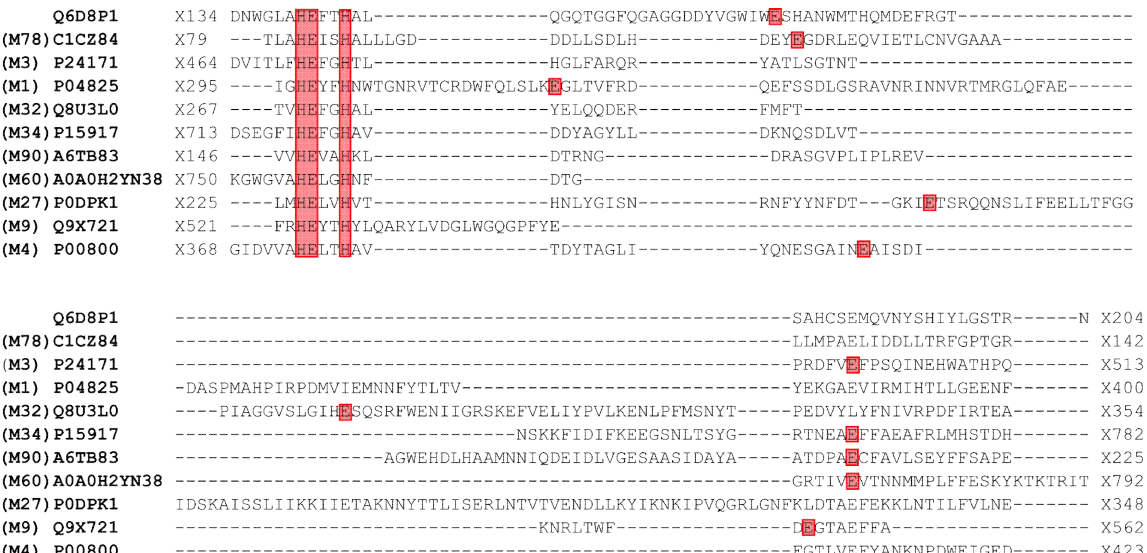
Figure 2. The alignment of the amino acid sequence of the Svx protein of Pectobacterium atrosepticum ( Pba ) (UniProt ID: Q6D8P1) with other bacterial gluzincin metallopeptidases with experimentally determined spatial structures: radiation response metallopeptidase IrrE Deinococcus deserti (UniProt ID: CICZ84) MEROPS family M78 [33], dipeptidyl carboxypeptidase Escherichia coli (UniProt ID: P24171) MEROPS family M3 [34], aminopeptidase N Escherichia coli (UniProt ID: P04825) MEROPS family M1 [35], thermostable carboxypeptidase 1 Pyrococcus furiosus (UniProt ID: Q8U3L0) MEROPS family M32 [36], lethal factor Bacillus anthracis (UniProt ID: P15917) MEROPS family M34 [37], protein MtfA Klebsiella pneumoniae (UniProt ID: A6TB8) MEROPS family M90 [38], ZmpB O-glycopeptidase Clostridium perfringens (UniProt ID: A0A0H2YN38) MEROPS family M60 [39], botulinum neurotoxin type X Clostridium botulinum (UniProt ID: P0DPK1) MEROPS family M27 [40], collagenase ColG Hathewaya histolytica (UniProt ID: Q9X721) MEROPS family M9 [41], thermolysin Bacillus thermoproteolyticus (UniProt ID: P00800) MEROPS family M4 [42]. The conservative zinc-binding motif HEXXHX(8,28)E is colored in red (the positions of the last glutamic acid (E) residues are variable in different proteins). The alignment was built using the MAFFT algorithm and the BLOSUM45 substitution matrix.